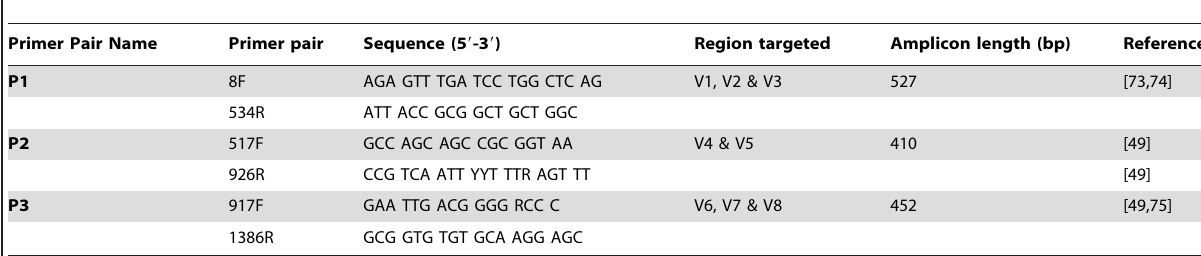
Table 1. PCR primer pair targeting different hyper variable regions of 16S rDNA.